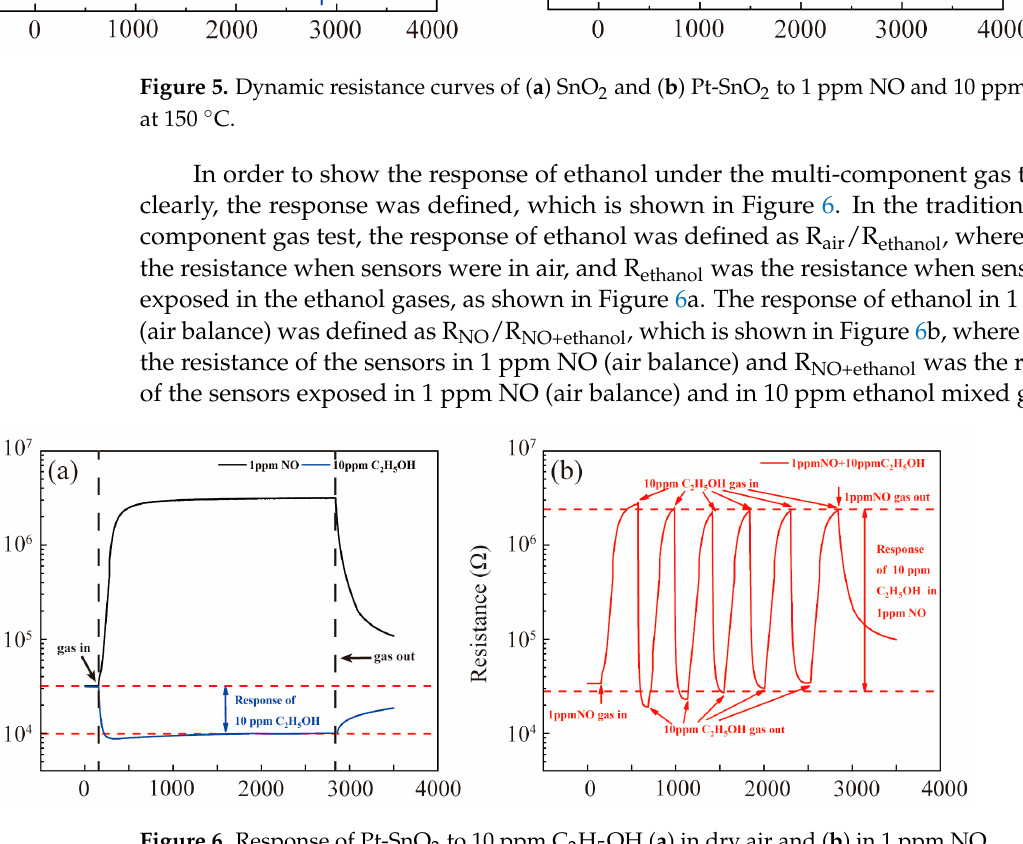
Figure 5. Dynamic resistance curves of ( a ) SnO 2 and ( b ) Pt-SnO 2 to 1 ppm NO and 10 ppm C 2 H 5 OH